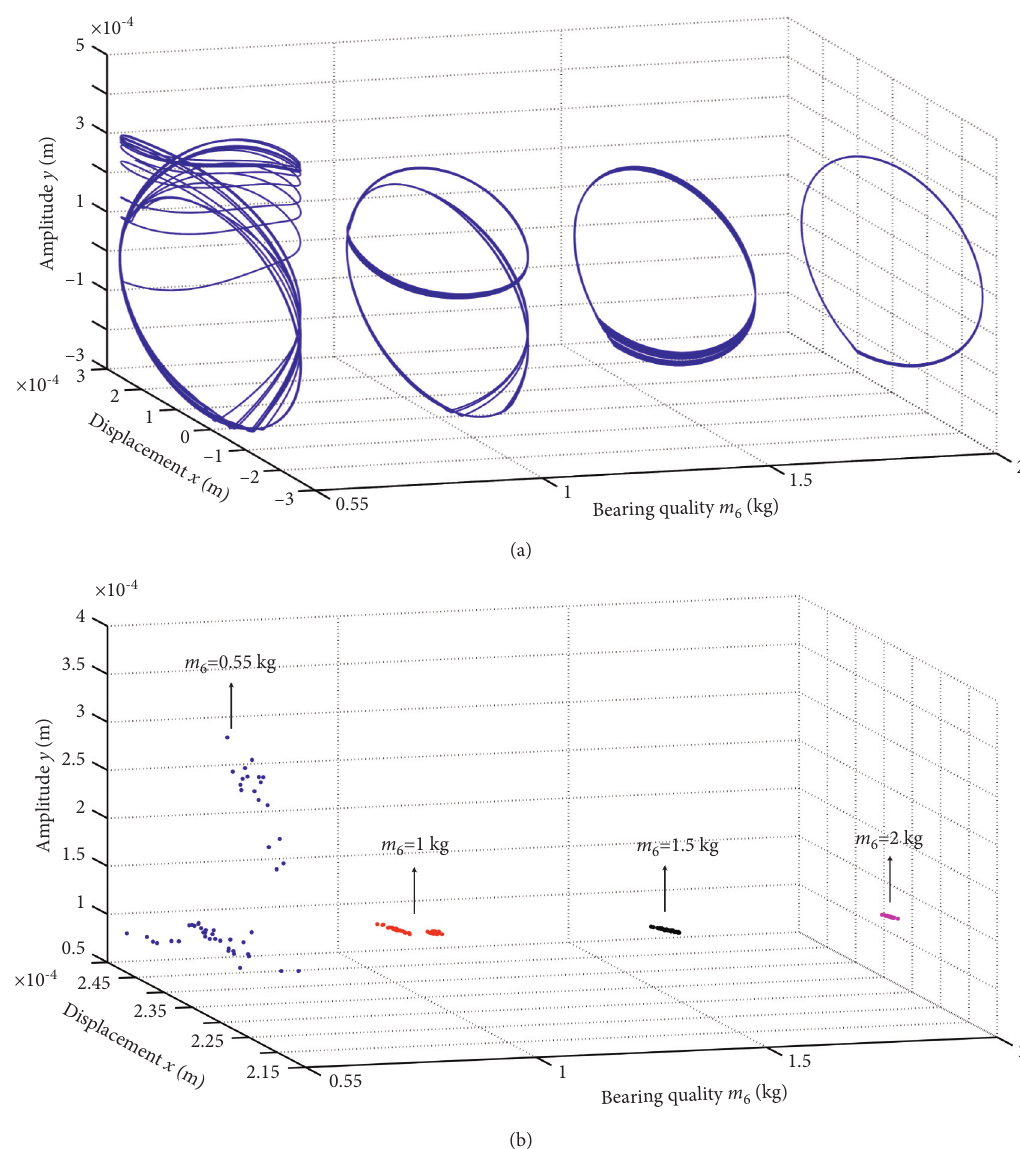
Figure 19: Rotor orbits and Poincar ´ e maps of the right journal with the change of the mass of the right bearing support. (a) Rotor orbits. (b) Poincar´e maps. ×10 -4 -31.56